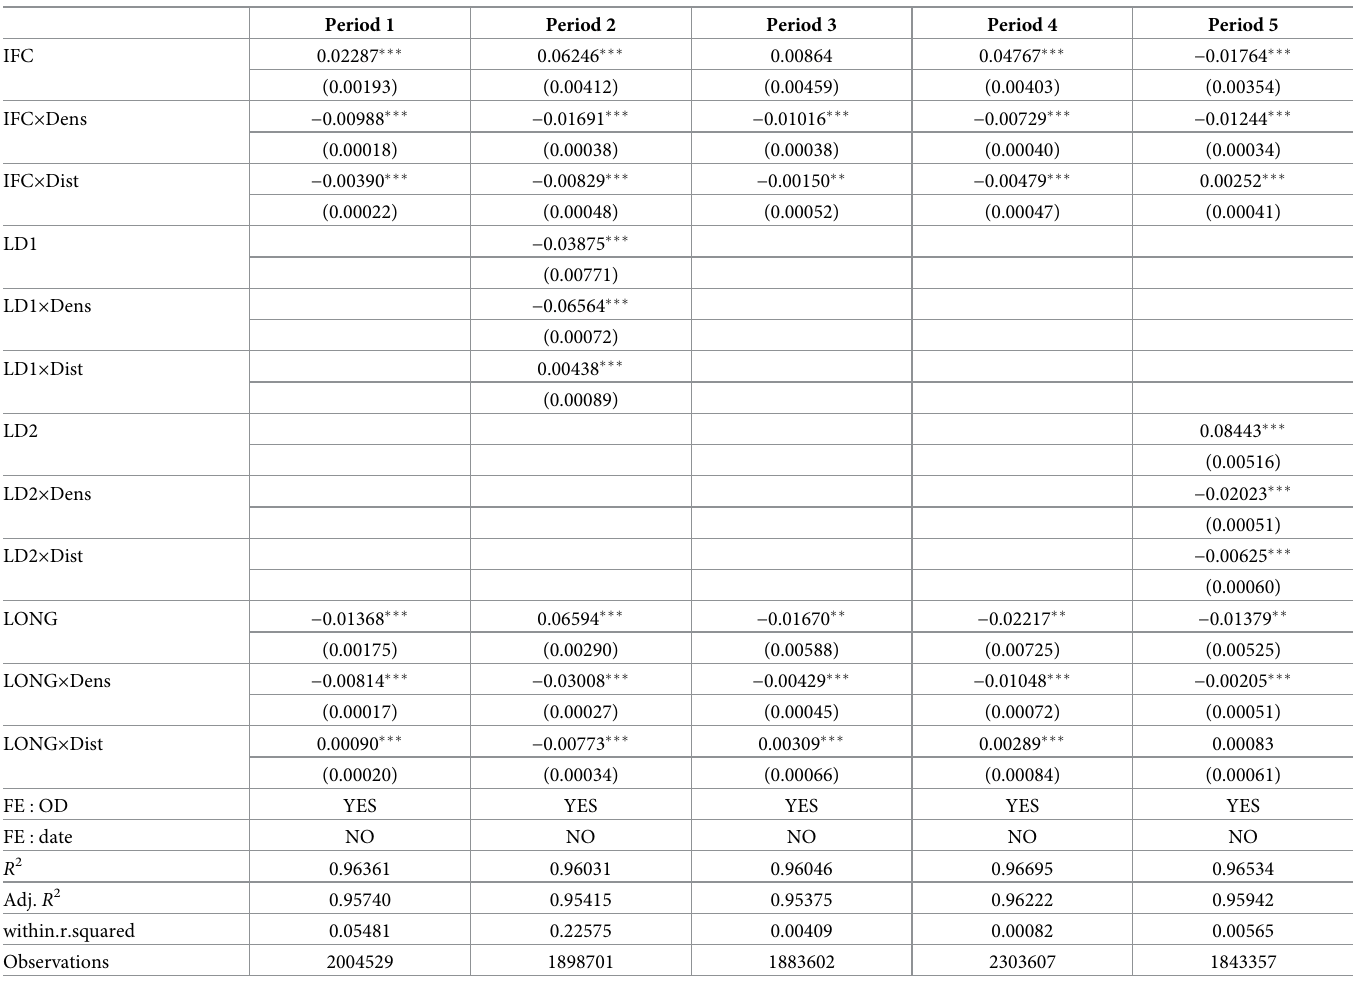
Table 2. Estimation results for detailed